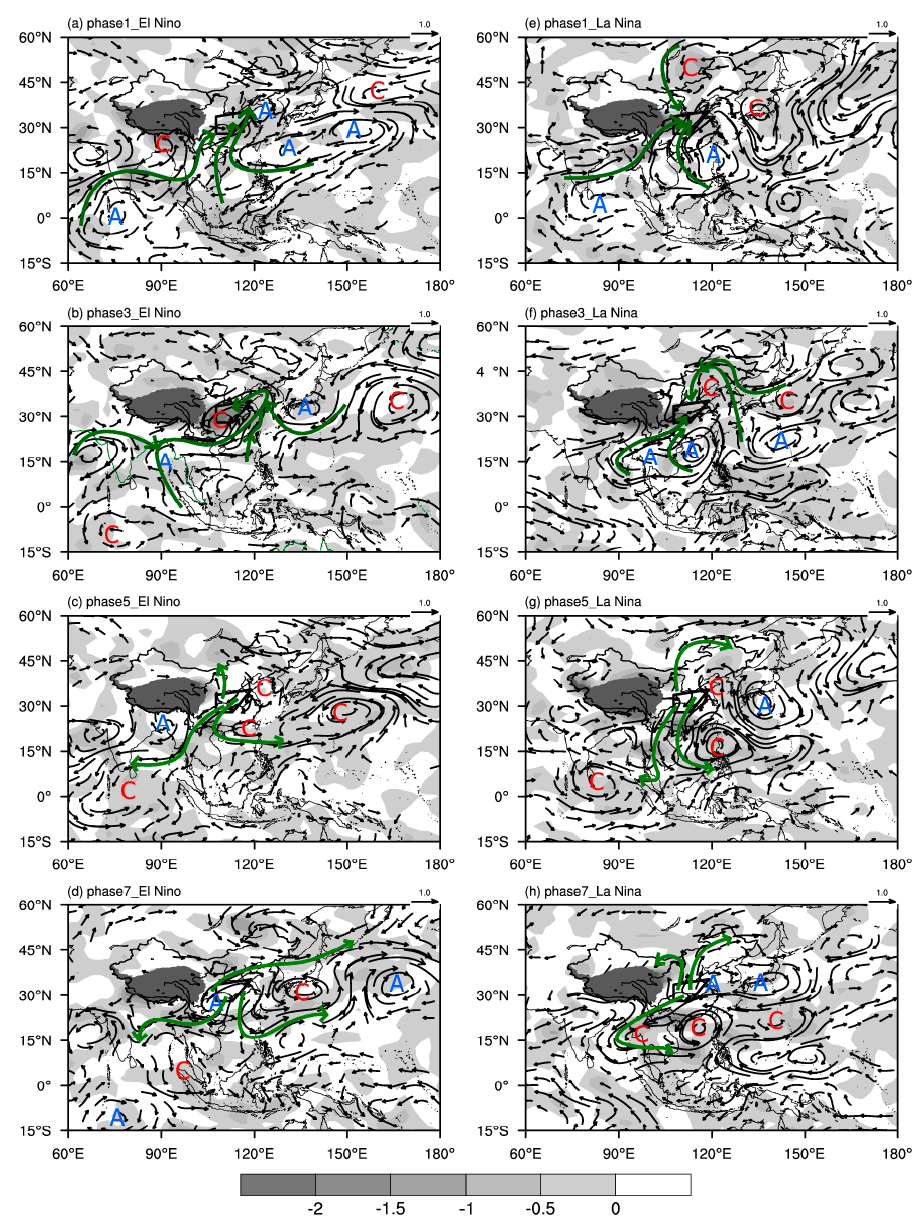
Figure 10. Same as Figure 5, but for the 10–20 d low-frequency water vapor flux fields (vector, units: kg · m − 1 · s − 1 ) and water vapor flux divergence fields (shaded areas represent water vapor convergent areas, units: 10 − 5 kg · m − 2 · s − 1 ).